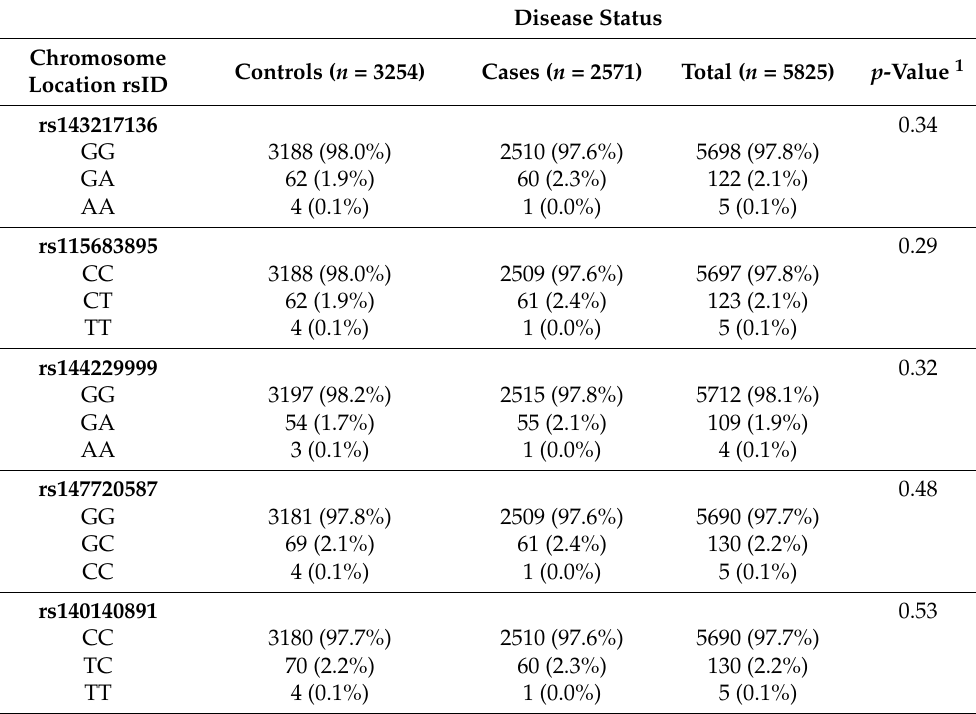
Table 2. Distribution of genotypic variants between POAG cases and controls for POAG-associated